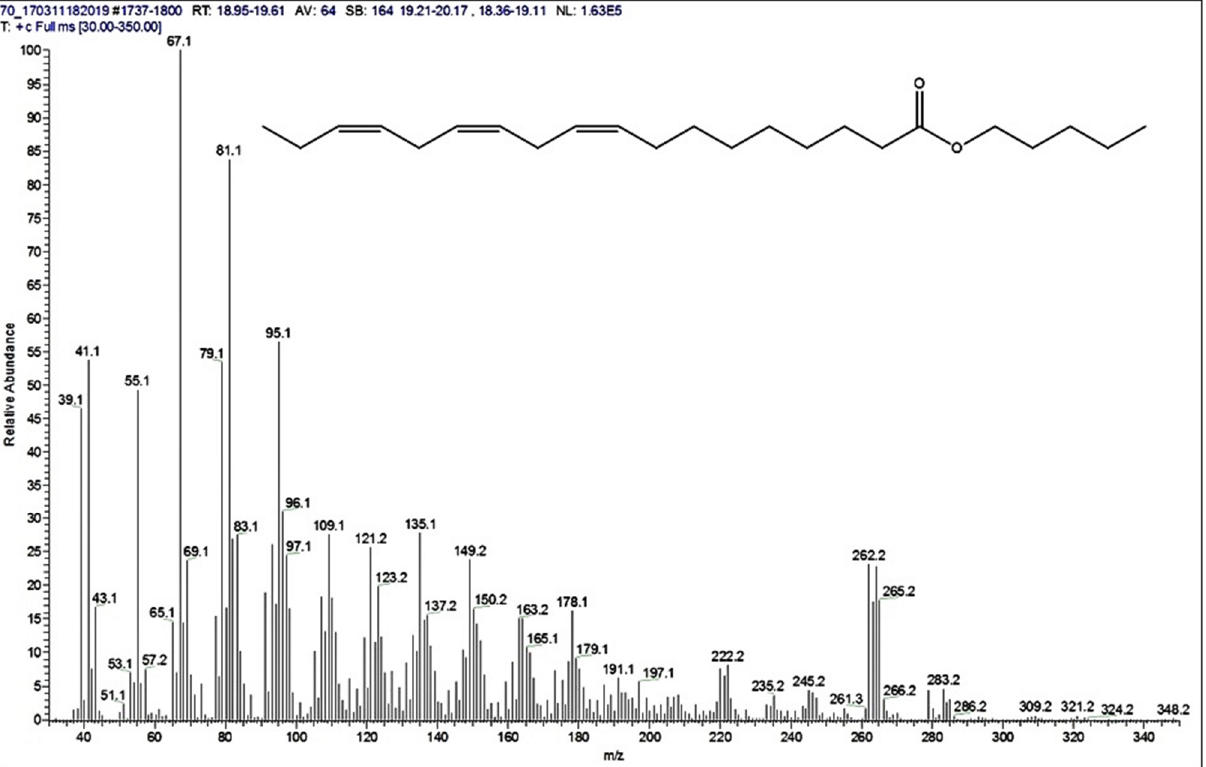
Figure 4. The mass spectrum of the ester, corresponding to the peak separated on the GC column at 19.15 min retention time (M = 348 g/mol), in the case of B3 bioester.